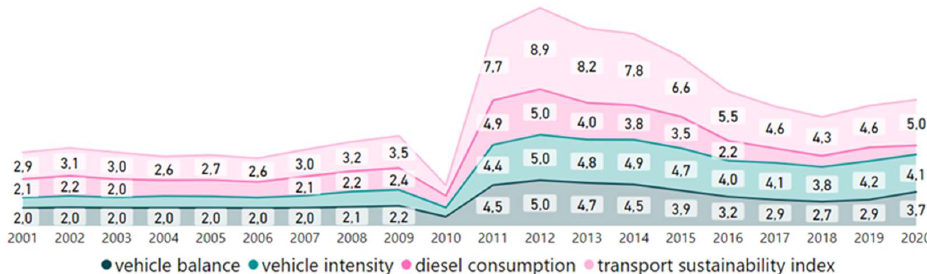
Figure 3. Interaction of dimensions of the transport sustainability index.